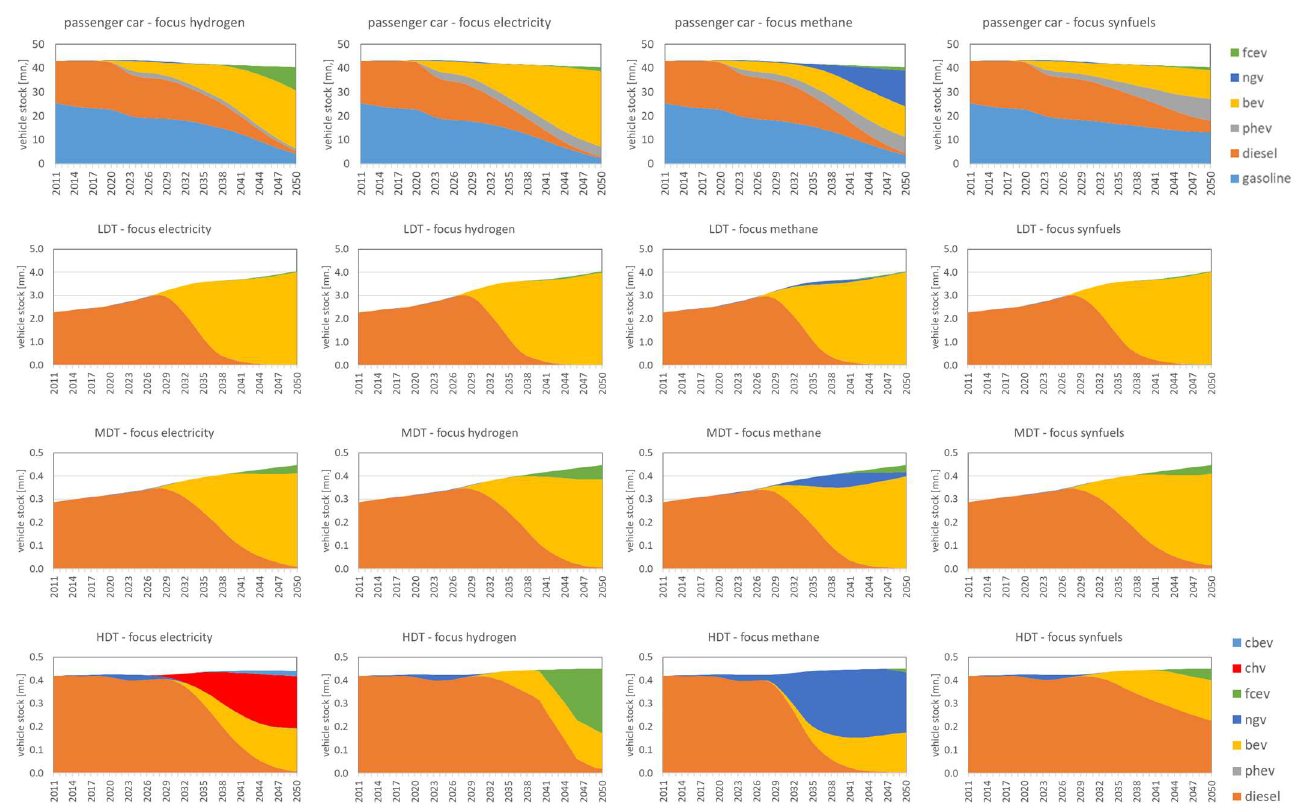
Figure 2. Vehicle stock in the four scenarios ( columns ) and vehicle size classes ( rows ). phev: plug-in hybrid electric vehicles: bev: battery electric vehicles; ngv: natural gas vehicles; fcev: fuel cell electric vehicles; chv: catenary hybrid electric vehicles; cbev: catenary battery electric vehicles. For passenger cars, we find at least 25% and up to 70% BEV in 2050. The number of gasoline and diesel cars are up to 30% in the first three scenarios and some reach 50% in focus synfuels. Hydrogen and NGV only play a role if their fuel prices are very low. Thus, a quite large number of passenger cars will be electric vehicles while the rest depends on fuel prices for synthetic fuels and hydrogen.